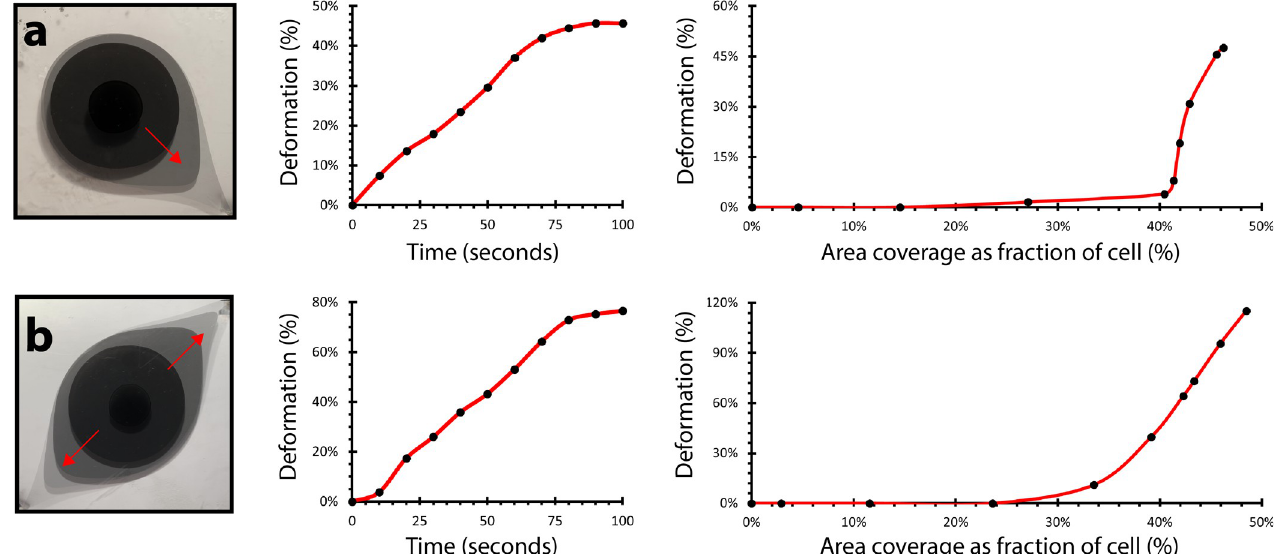
Fig 5. Non-normalized (a) single-outlet and (b) multioutlet droplet deformation as a function of time (left graphs) and area-normalized droplet deformation as a function of fractional area coverage (right graphs), proportional to dispersed pigment volume (flow rate = 25 mL/min).